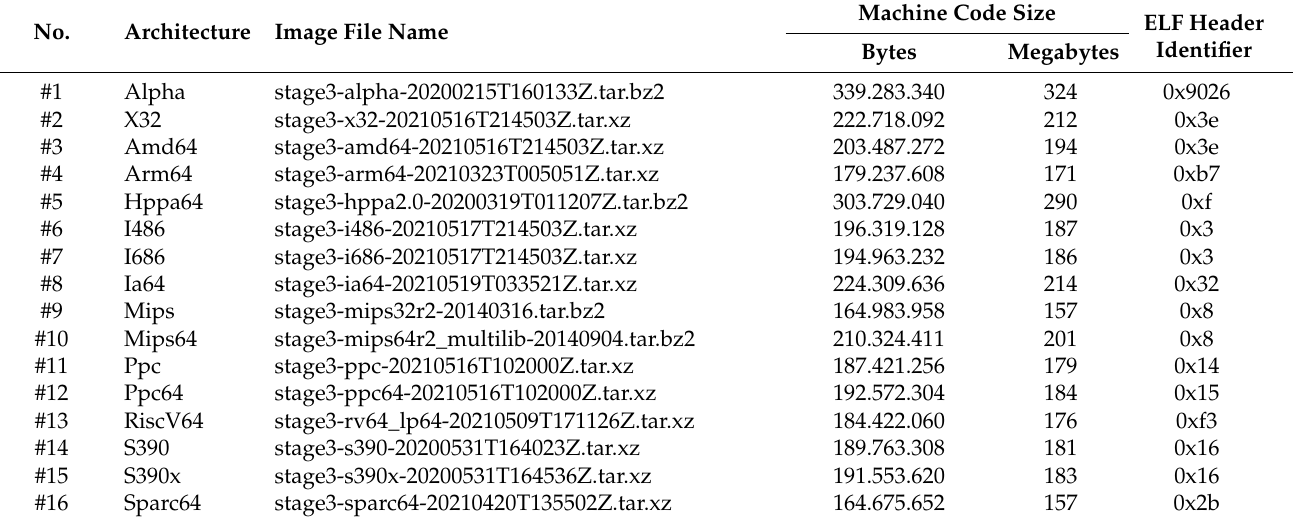
Table 1. Size of all executable files for each Top-16 Architecture for the